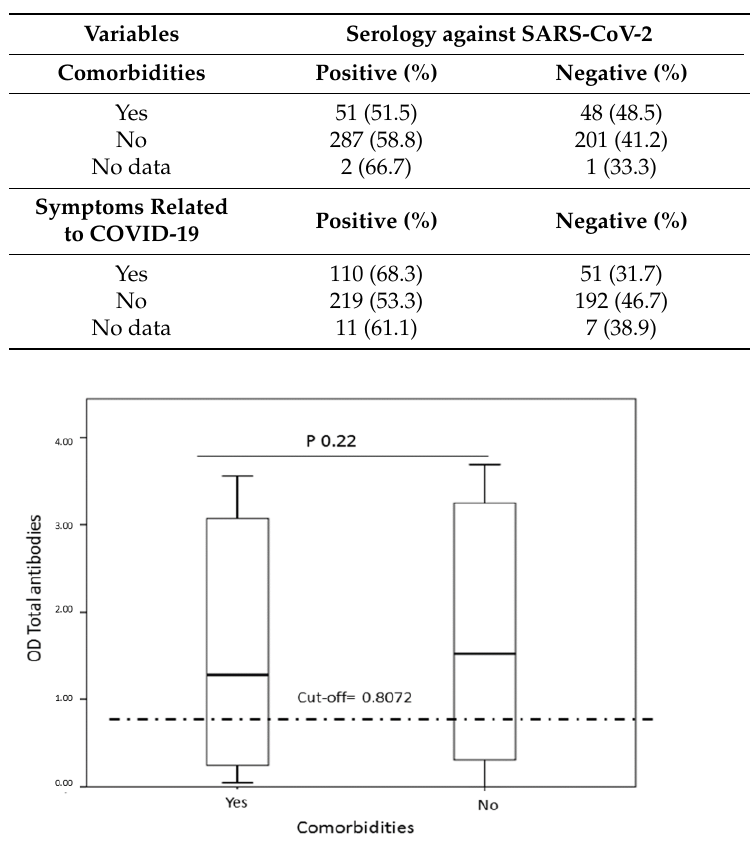
Figure 4. Relationship between having some comorbidity versus the serological data for SARS-CoV-2. No statistically significant differences were observed when comparing the total antibody kinetics between individuals with comorbidity versus those who did not.